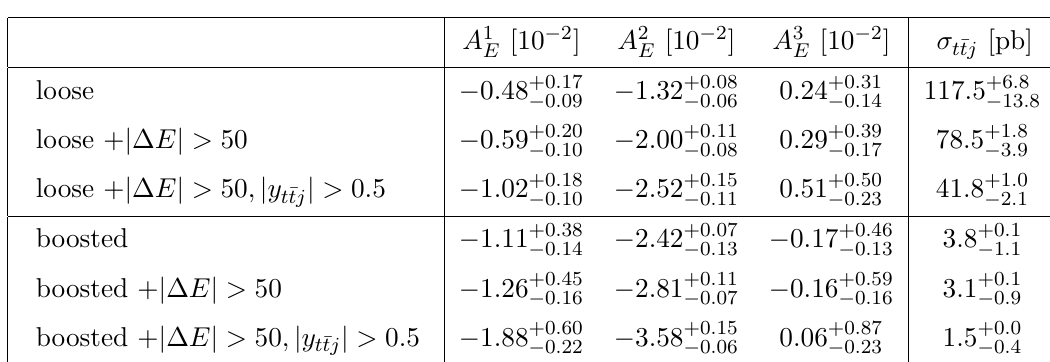
Figure 1 . Parton-level predictions at NLO QCD for the di(cid:11)erential cross section ( d(cid:27) opt =d(cid:18) j ) (cid:2)B 1 ‘ t (cid:22) tj p (left) and the energy asymmetry A opt ( (cid:18) j ) (right) at the LHC with s = 13 TeV as functions of E the jet angle (cid:18) j . Shown are three di(cid:11)erent kinematic selections in the boosted top regime. Vertical error bars show statistical uncertainties from the event simulation; colored bands show the scale uncertainties.